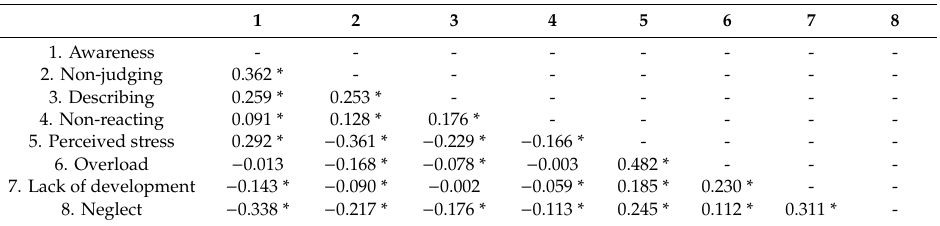
Table 2. Pearson correlations among all variables in the model.